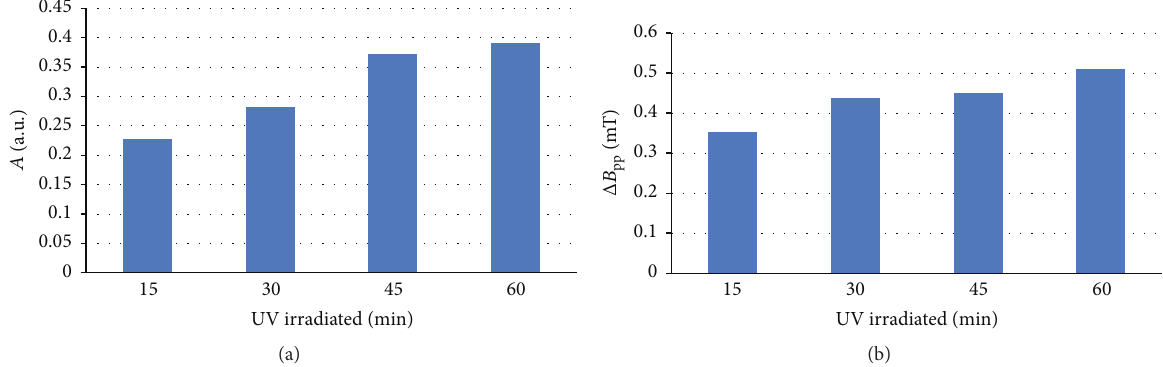
Figure 4: Comparison of (a) amplitudes ( 𝐴 ) and (b) linewidths ( Δ𝐵 pp ) of EPR spectra of urea after UV irradiation in different times.